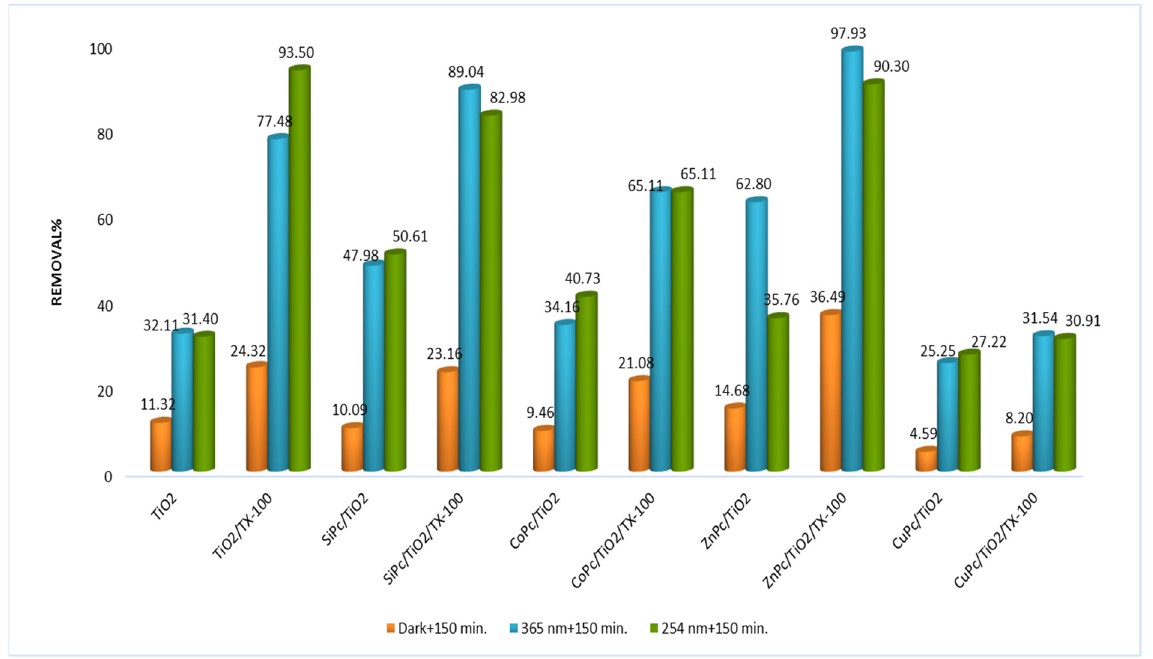
Figure 9. Comparison of photocatalytic removal of Cr(VI) ([Cr(VI)] 0 = 10 mg/L, mass = 1 g/L, t = 150 min). Cr(VI) reduction is lower than 0.5% in the presence of MPc alone under the same condition.